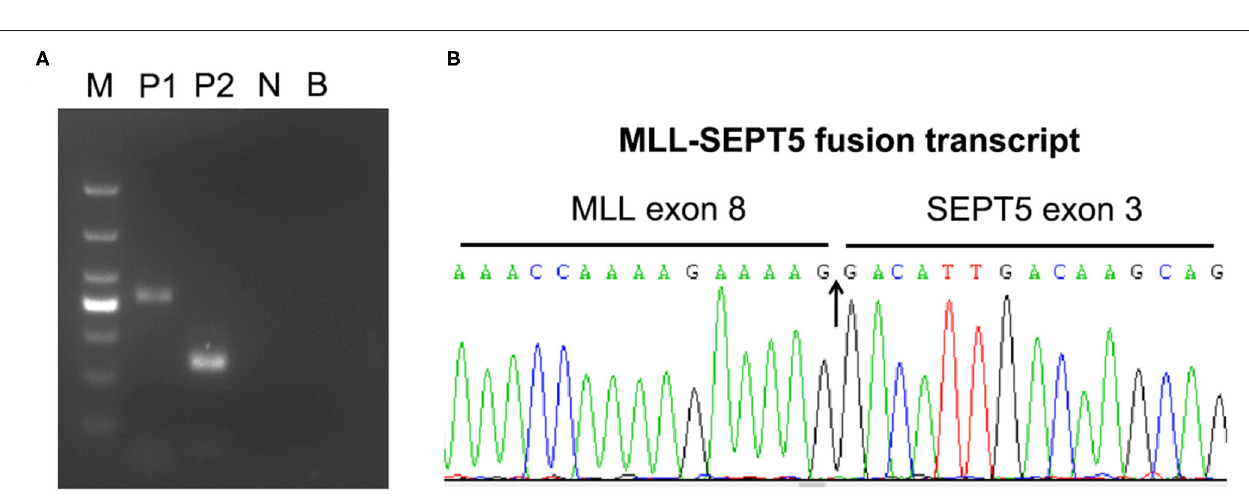
FIGURE 3 | RT-PCR analyses of MLL-SEPT5 fusion transcript. (A) The products were detected with 2% agarose gel electrogenesis after amplification. M, DNA marker (TaKaRa, 3591A); P1, patient sample (primer combination: MLL-E7 and SEPT5-E5); P2, patient sample (primer combination: MLL-E7 and SEPT5-E3); N, PCR control; B, blank control. (B) Sequence analysis of the SEPT5-MLL fusion transcript showing juxtaposition of MLL exon 8 and SEPT5 exon